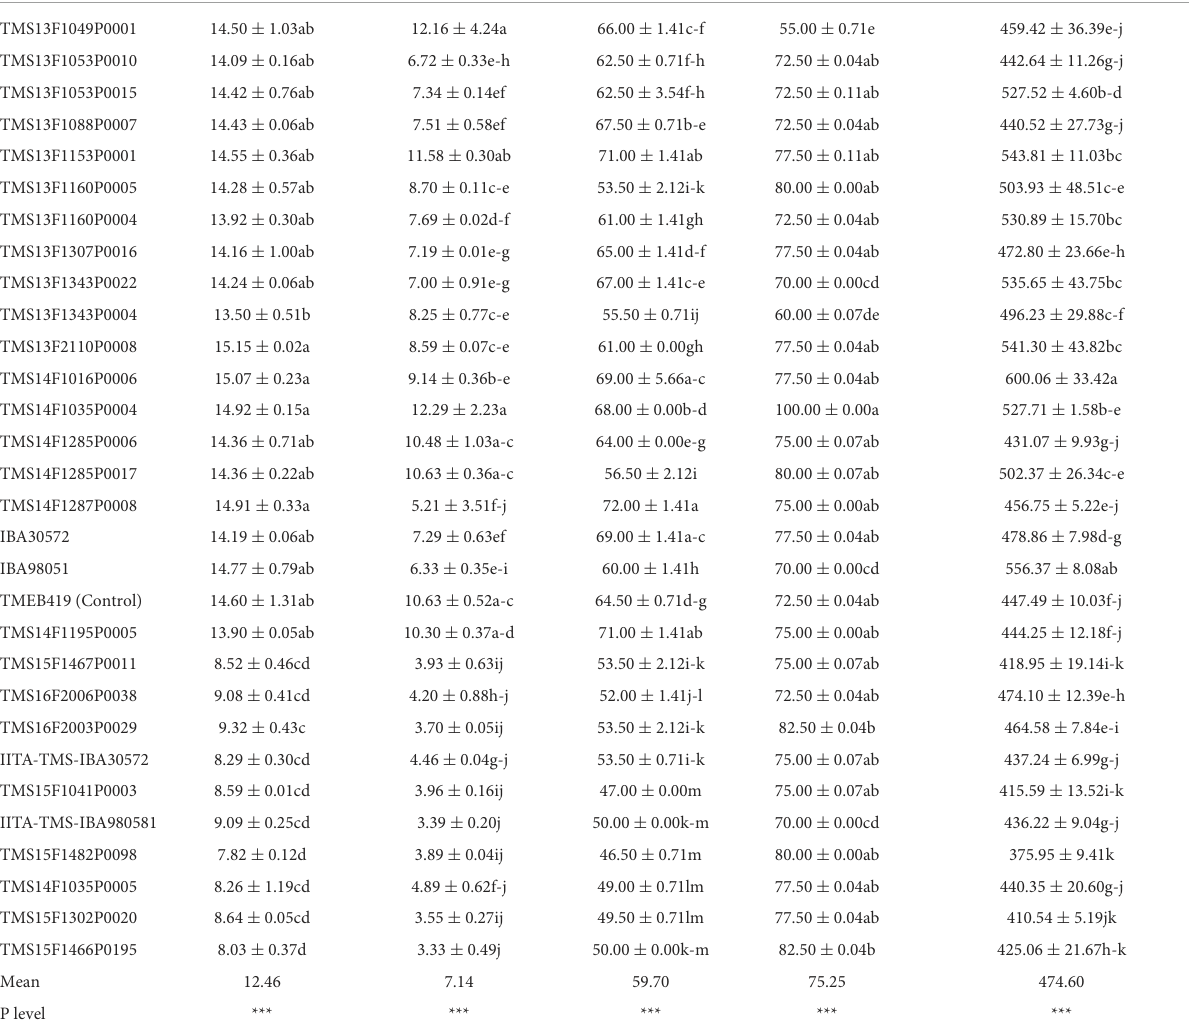
TABLE 2 Functional properties of gari produced from the cassava genotypes and the control variety. Cassava varieties Swelling power (%) Solubility index (%) Dispersibility (%) Bulk density (%) Water absorption capacity